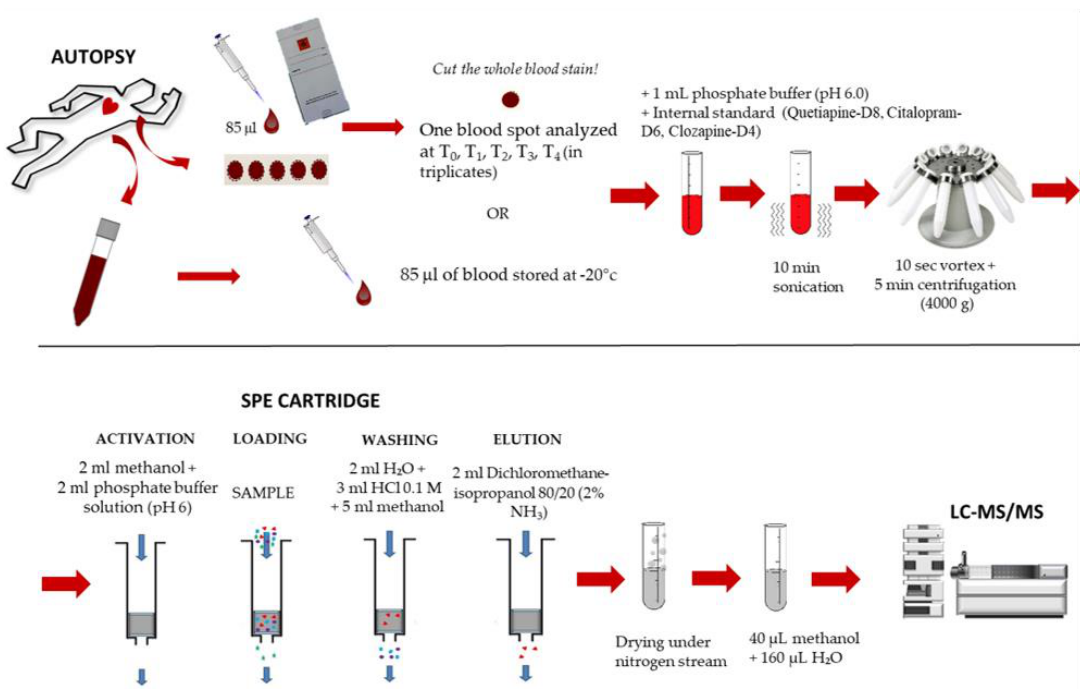
Figure 20. Sample preparation and Figure 20: Sample preparation and extraction.